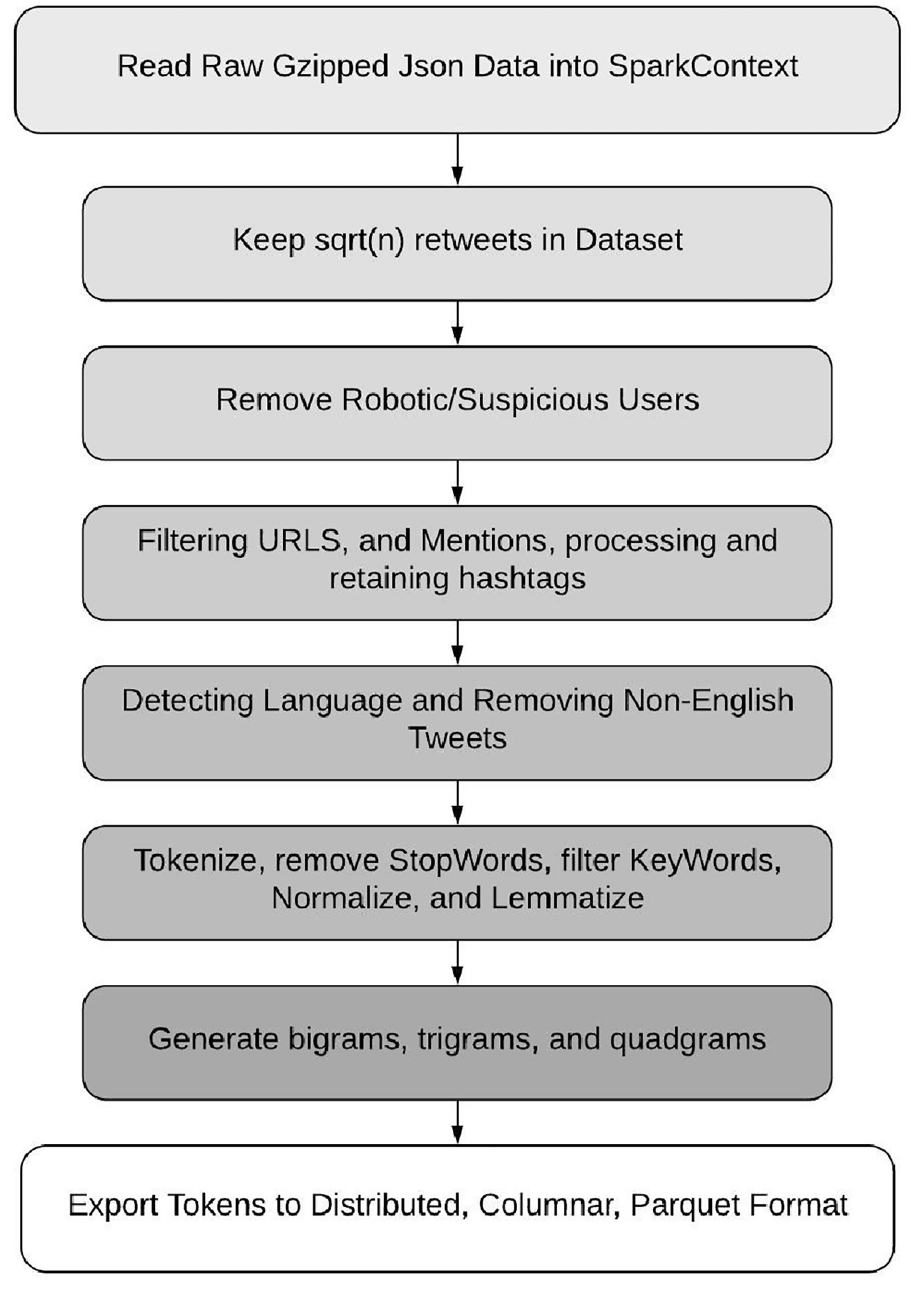
Fig 1. Dataset preprocessing